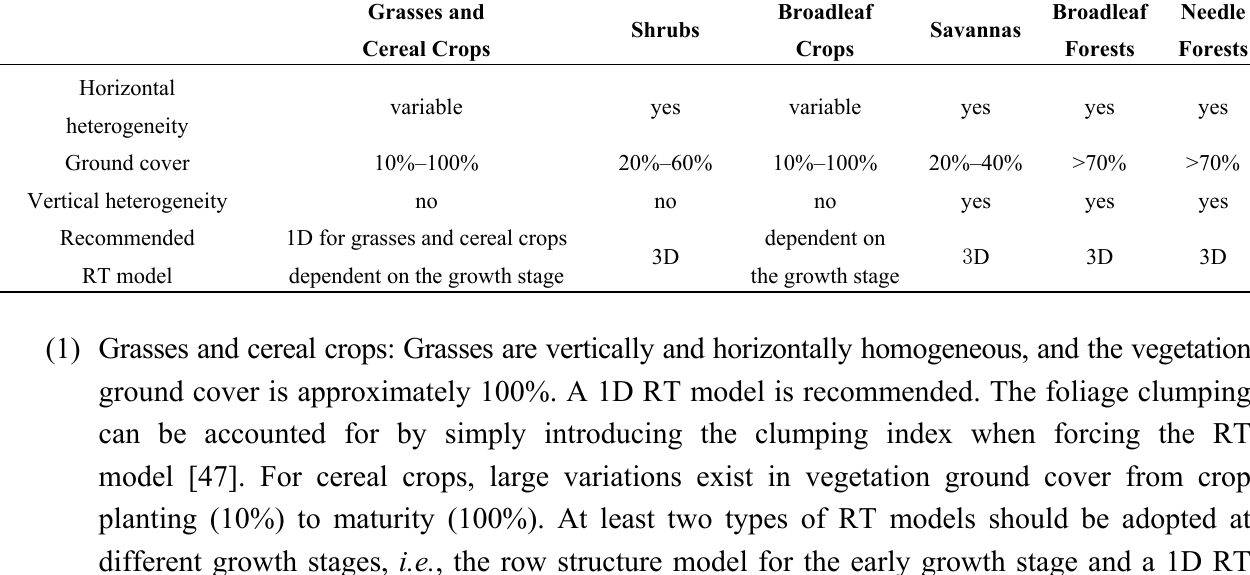
Grasses and Cereal Crops